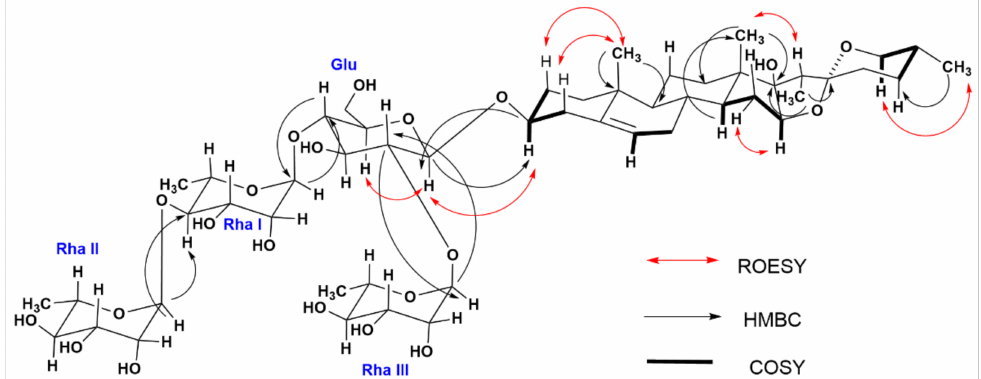
Figure 5. Summary of spectroscopic (NMR) results of the amorphous precipitate which corresponds to ECn-F4-25. Key correlations determined by COSY (black lines), HMBC (black single-headed arrows) and ROESY (red double-headed arrows) experiments for pennogenin tetraglycoside. Supporting data are explained in the text and provided in the Supplementary